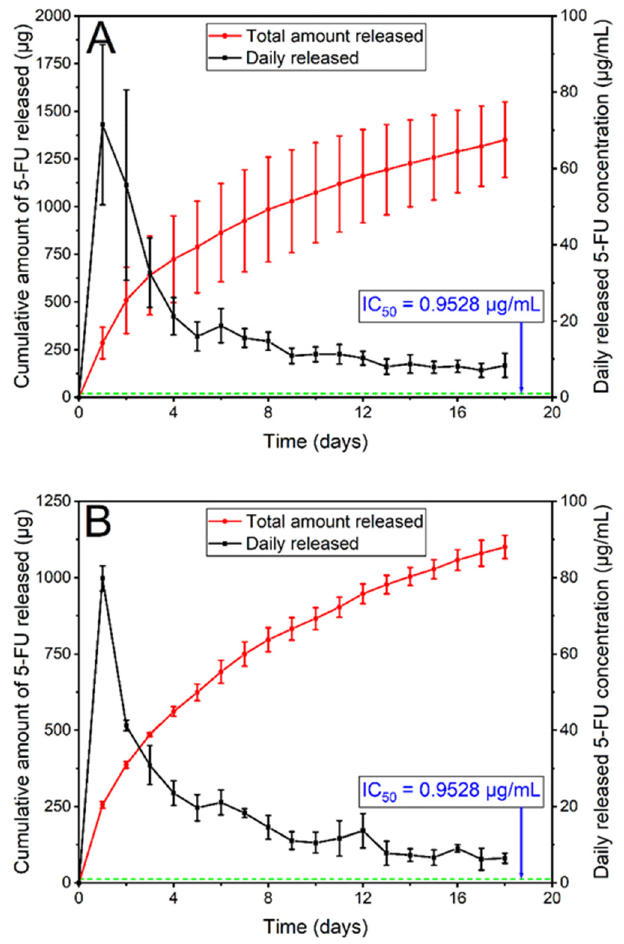
Figure 8. In vitro release of 5FU from ( A ) Si-PU 5FU -PEVA and ( B ) B-PU 5FU -PEVA stent sections over 18 d in 4 mL and 3.2 mL of 10% v/v FBS-supplemented sterile RPMI-1640 medium, respectively. Data expressed as mean ( n = 3) ± SD.